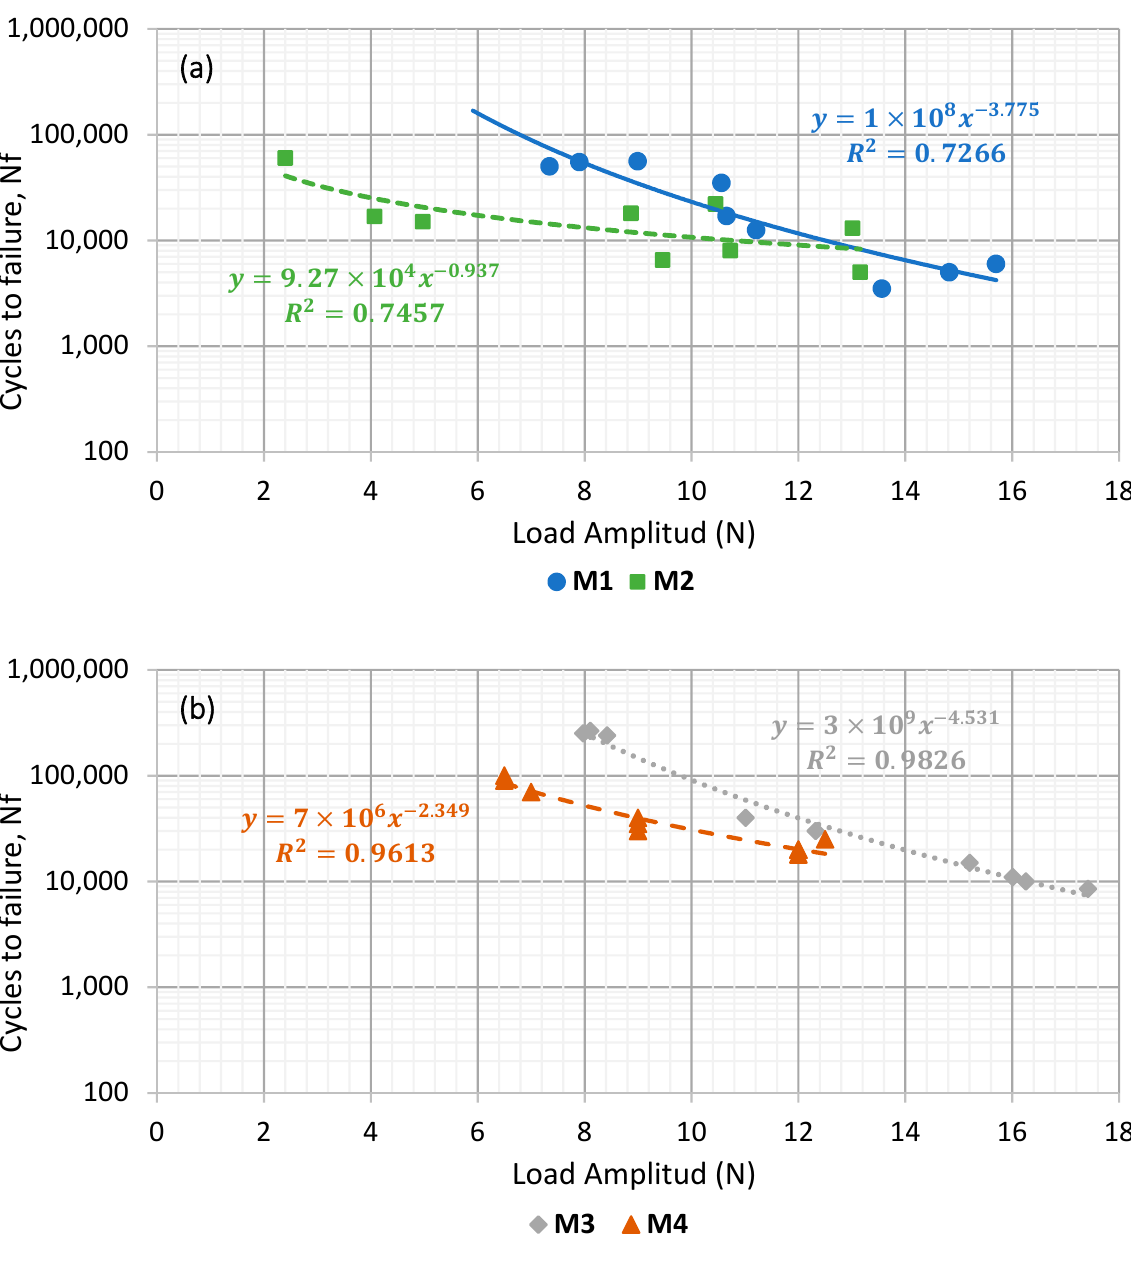
Figure 9. Comparison between types of active filler for mortars manufactured with penetration binder ( a ) and polymer-modified bitumen ( b ).